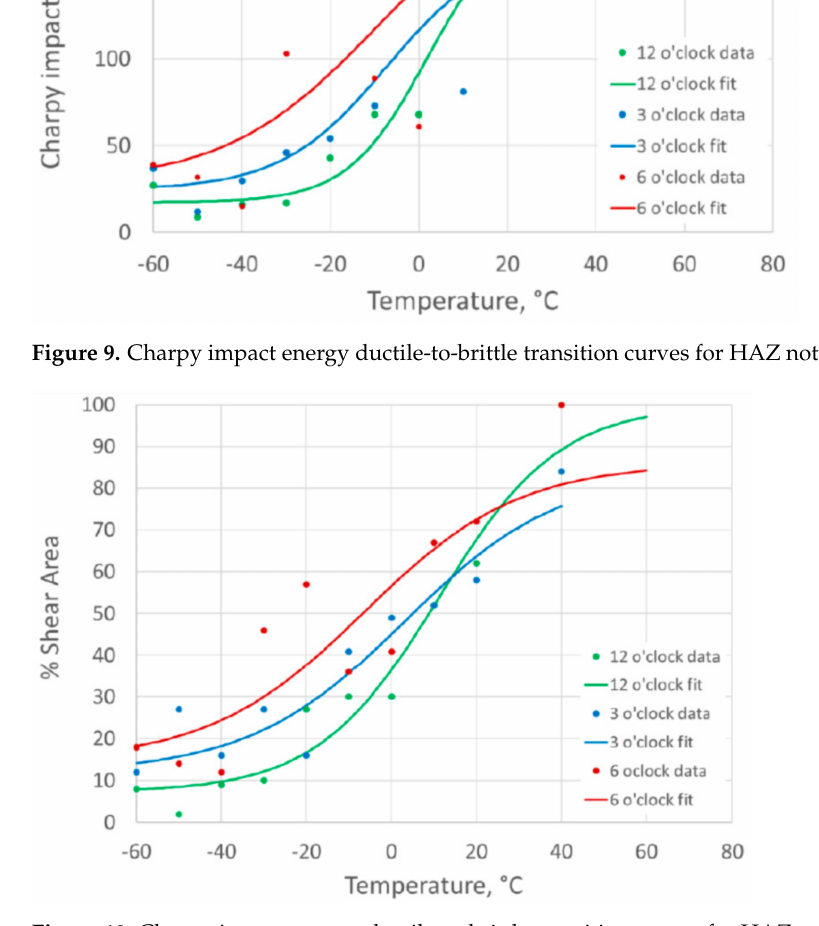
Figure 10. Charpy impact energy ductile-to-brittle transition curves for HAZ notched specimens. Table 2. Charpy T 40 J transition temperatures for girth weld and HAZ at different clock